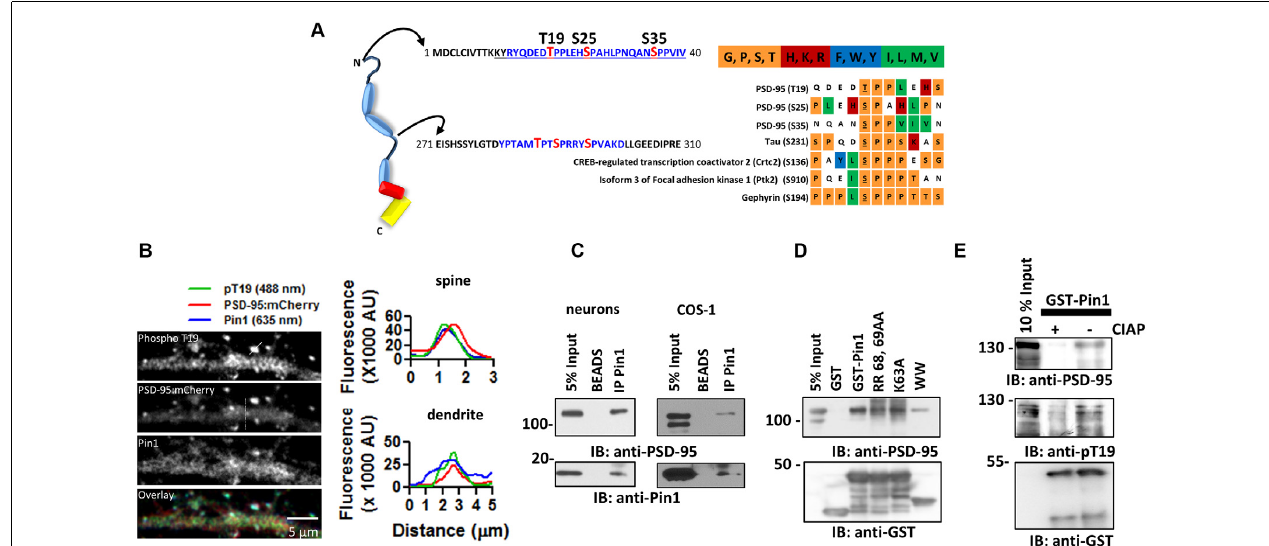
FIGURE 1 | The peptidylprolyl cis-trans isomerase NIMA-interacting 1 (Pin1) interacts with postsynaptic density protein-95 (PSD-95) via its WW domain. (A) (Left) Schematic diagram of PSD-95 indicating putative Pin1 binding sites (shown in blue). (Right) Amino acid sequence alignment oriented around the S/T-P motifs. A chart was generated using the PRALINE algorithm. Color-code based on amino acid groups; shown above in abbreviated form. (B) Pin1 co-localizes with phosphorylated PSD-95 in vivo . Representative confocal images of hippocampal neurons transfected with PSD-95::mCherry (2 nd image) and immunostained against phospho-T19 (Top) and Pin1 (3 rd image) and overlay image (lower). Line scans above a dendrite and a dendritic spine (white lines) showing good co-localization on spines (top) and dendrites (bottom), right graphs. (C) PSD-95 Pin1 interaction is present in vivo . Neurons experiments performed on endogenous proteins.